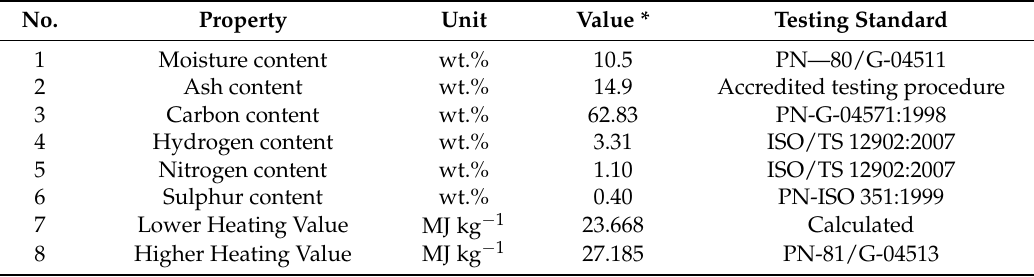
Table 1. Properties of hard coal used in the tested steam boiler.